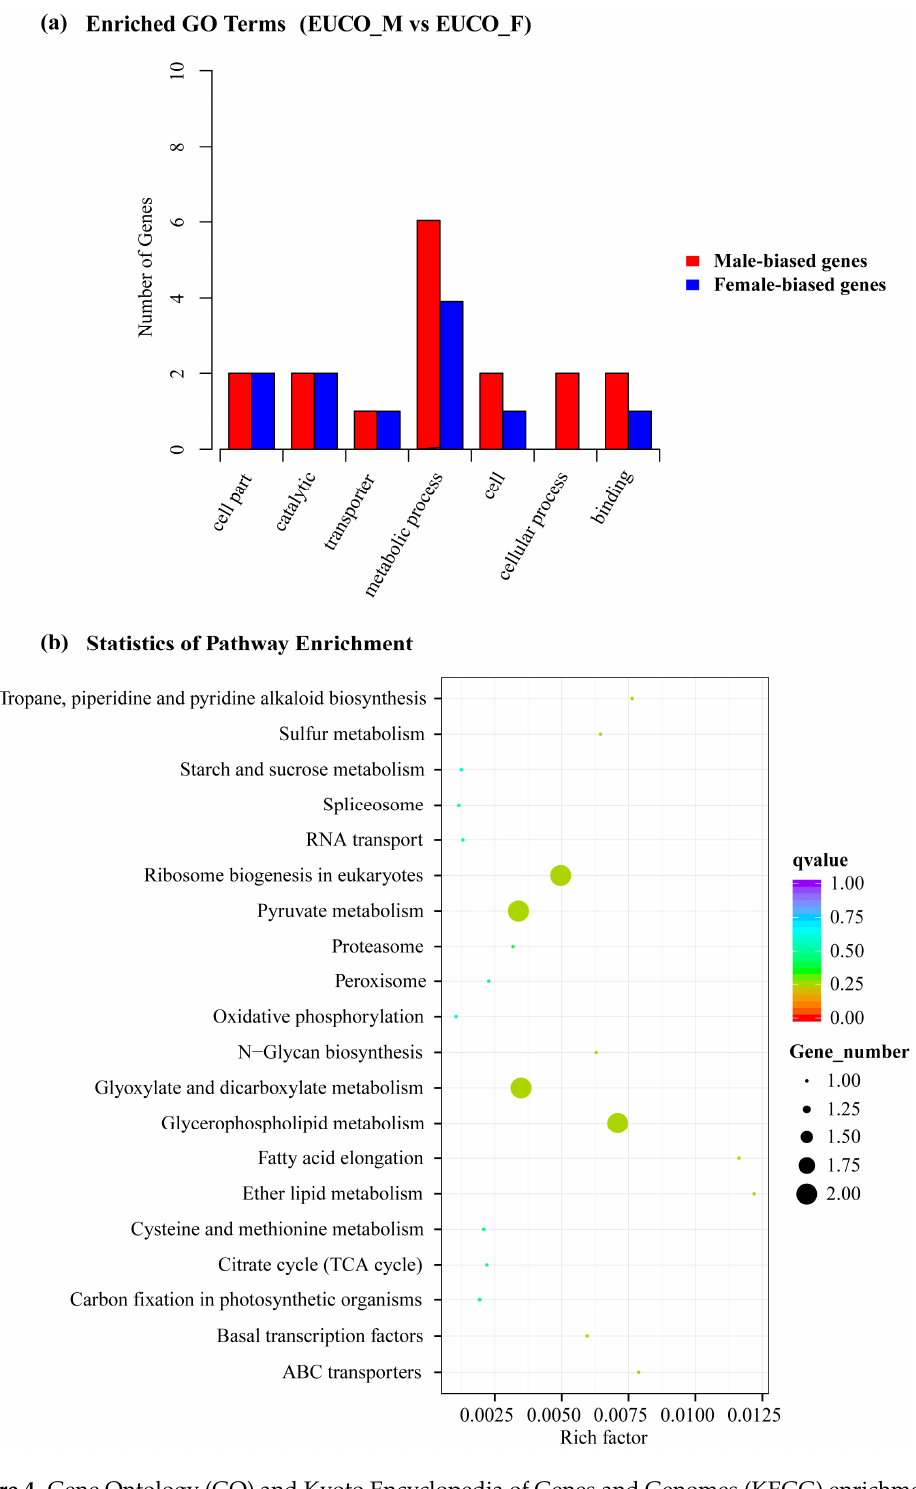
Figure 4. Gene Ontology (GO) and Kyoto Encyclopedia of Genes and Genomes (KEGG) enrichments of 116 DEGs (differentially expressed genes) between the males and the females of Eucommia ulmoides . ( a ) Statistics of GO terms enrichment of the DEGs. The Y -axis represents the number of DEGs in a category. EUCO_M: Males; EUCO_F: Females; ( b ) Statistics of KEGG pathway enrichment of the DEGs. The Y axis represents the different KEGG pathways, and the X axis shows the rich factor. The color scale indicates the q -value range, and the size of the circles means the gene numbers.